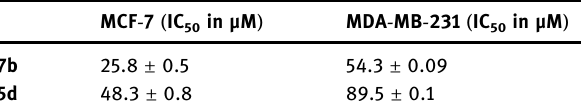
Table 1: The concentration with 50% inhibition ( IC 50 in µM ) of derivatives 7b and 5d against breast cancer cell lines, MCF7 and